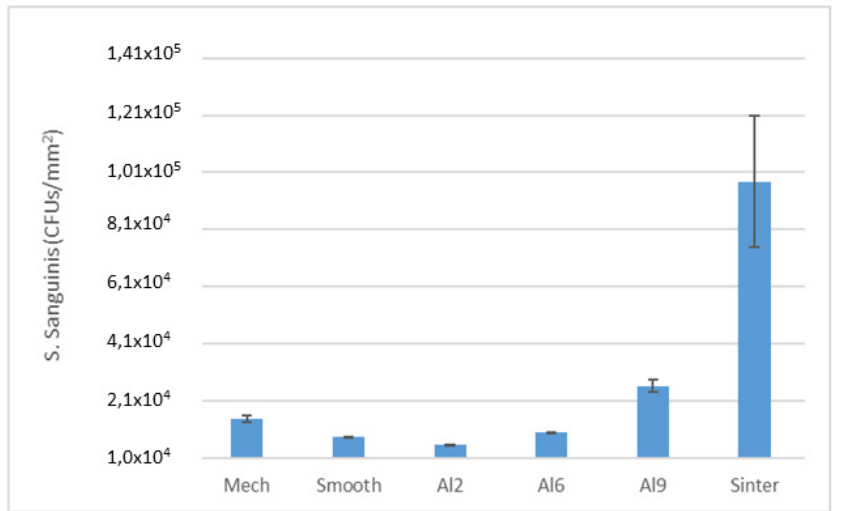
Figure 8. CFUs/mm 2 of Streptococcus sanguinis for the different treatments studied. Each symbol means that the results were different with statistical significance to the other symbols at p < 0.01. For this bacterial strain, the Sinter and Al9 surfaces showed statistically significant differences between them and the rest of the samples. The Al6 and Mech surfaces did not show any differences and neither did the Al2 and Smooth surfaces, but there were differences between the other surfaces.